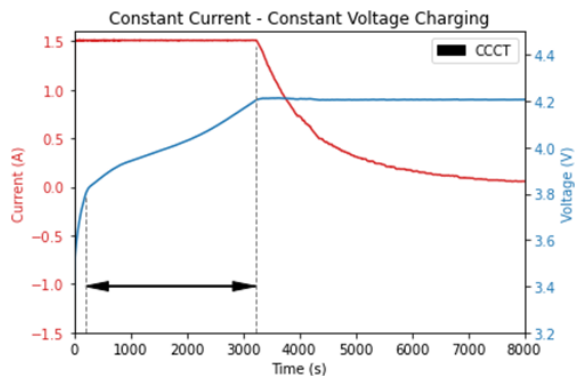
Figure 3. The charge voltage and charge current curves for Cycle 10.